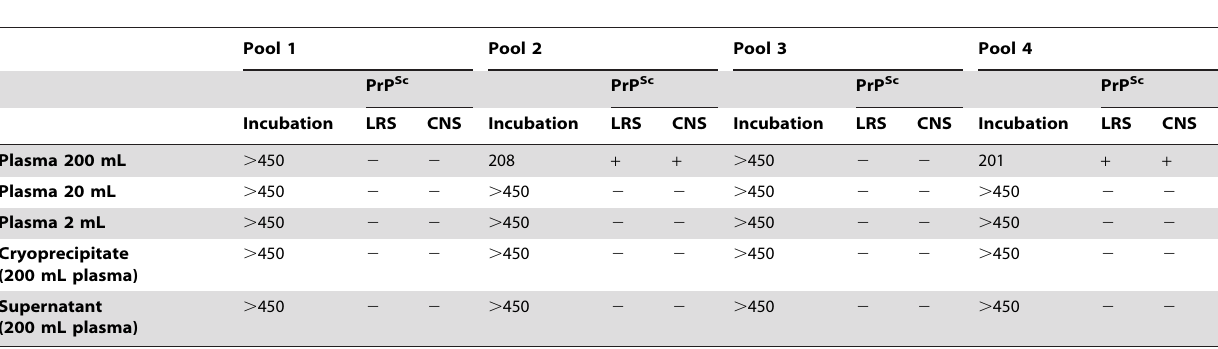
Table 4. TSE occurrence in VRQ/VRQ TSE free sheep transfused with frozen plasma and plasma fractions prepared from Scrapie infected sheep.